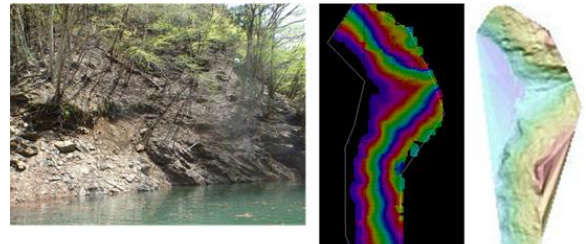
Figure 14. Application of the developed boat-loading system utilized in terrain surveying around a Figure 12. Developed vehicle-loading system for road surface inspection and Japanese official certification of road surface inspection